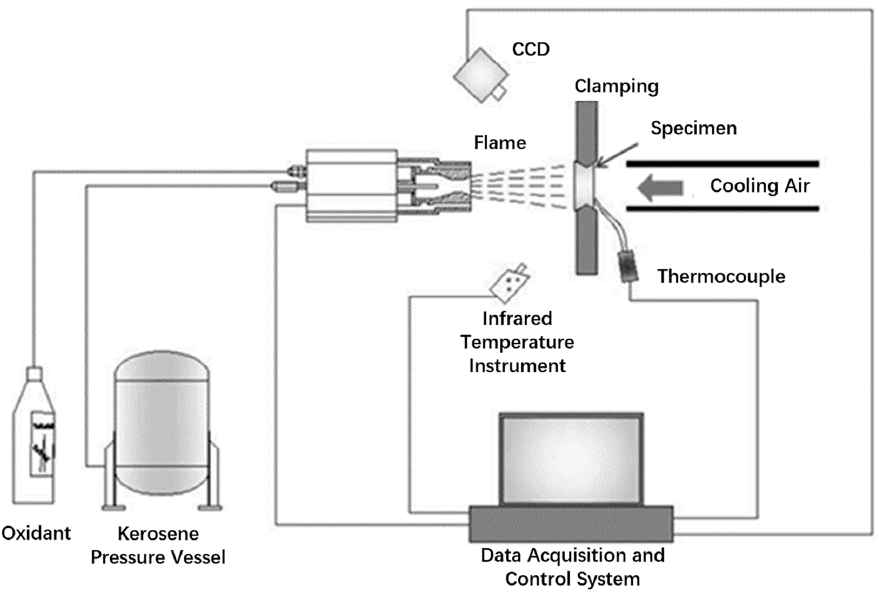
Figure 2. Schematic of function principle for the service environment simulation device.